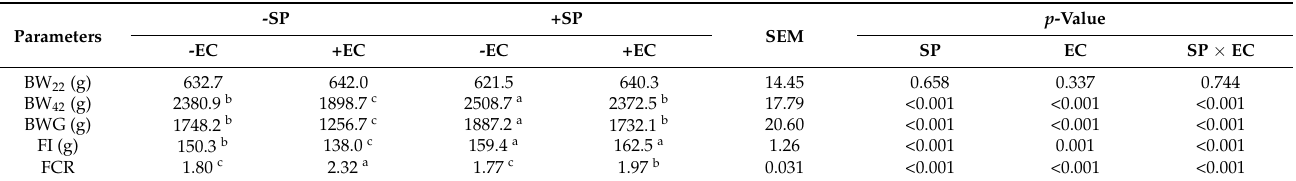
Table 3. Effect of dietary Spirulina platensisis (SP) supplementation on the growth performance of broilers challenged by Escherichia coli (EC)